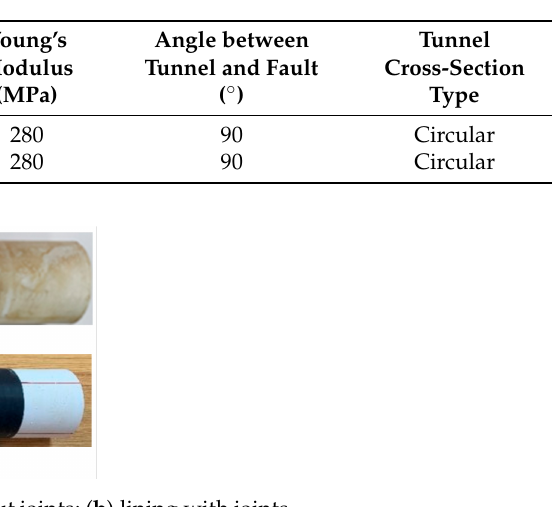
Table 3. Cases of Model Tests.